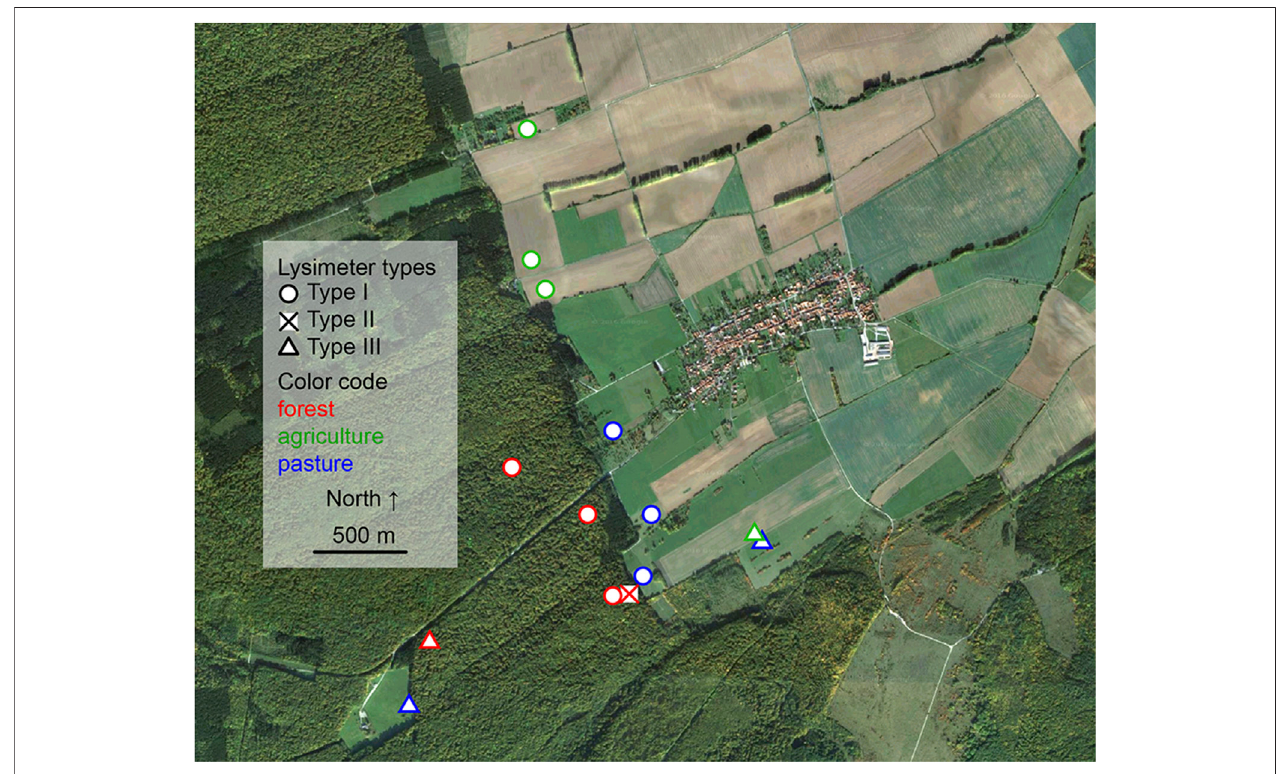
FIGURE 1 | Satellite image of the sampling transects including highlighted sampling spots. “ Map data: Google, DigitalGlobe 2016 ” .